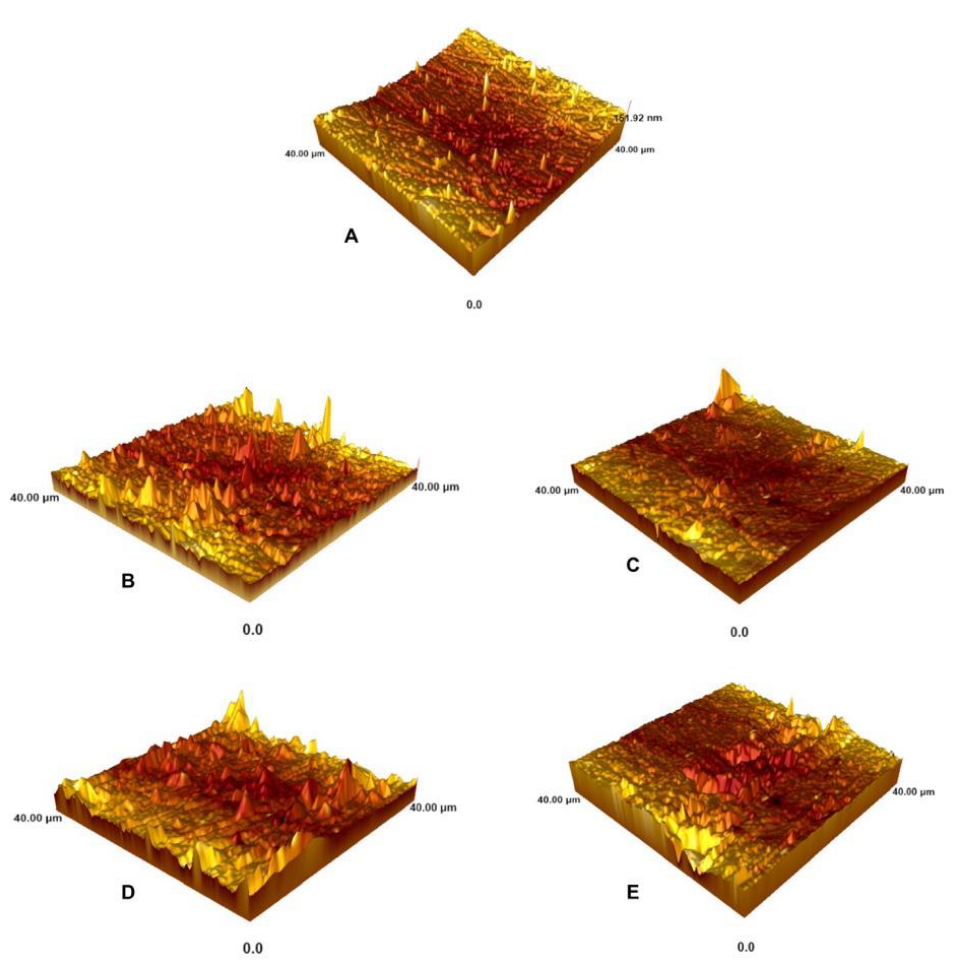
Figure 3. Three-dimensional atomic force microscopy images before and after the application of bleaching gels with different HP concentrations: ( A ) no bleaching (control); ( B ) bleaching with 40% HP + F; ( C ) bleaching with 35% HP + Ca; ( D ) bleaching with 25% HP + nHA; ( E ) bleaching with 18% HP + nHA.